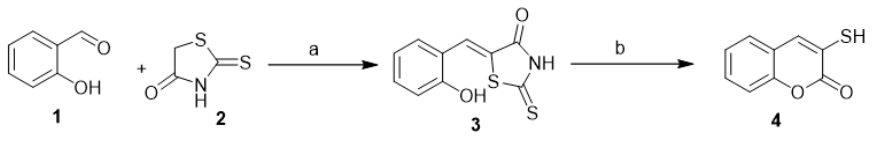
Figure 1. The four common mercapto-coumarin derivatives.